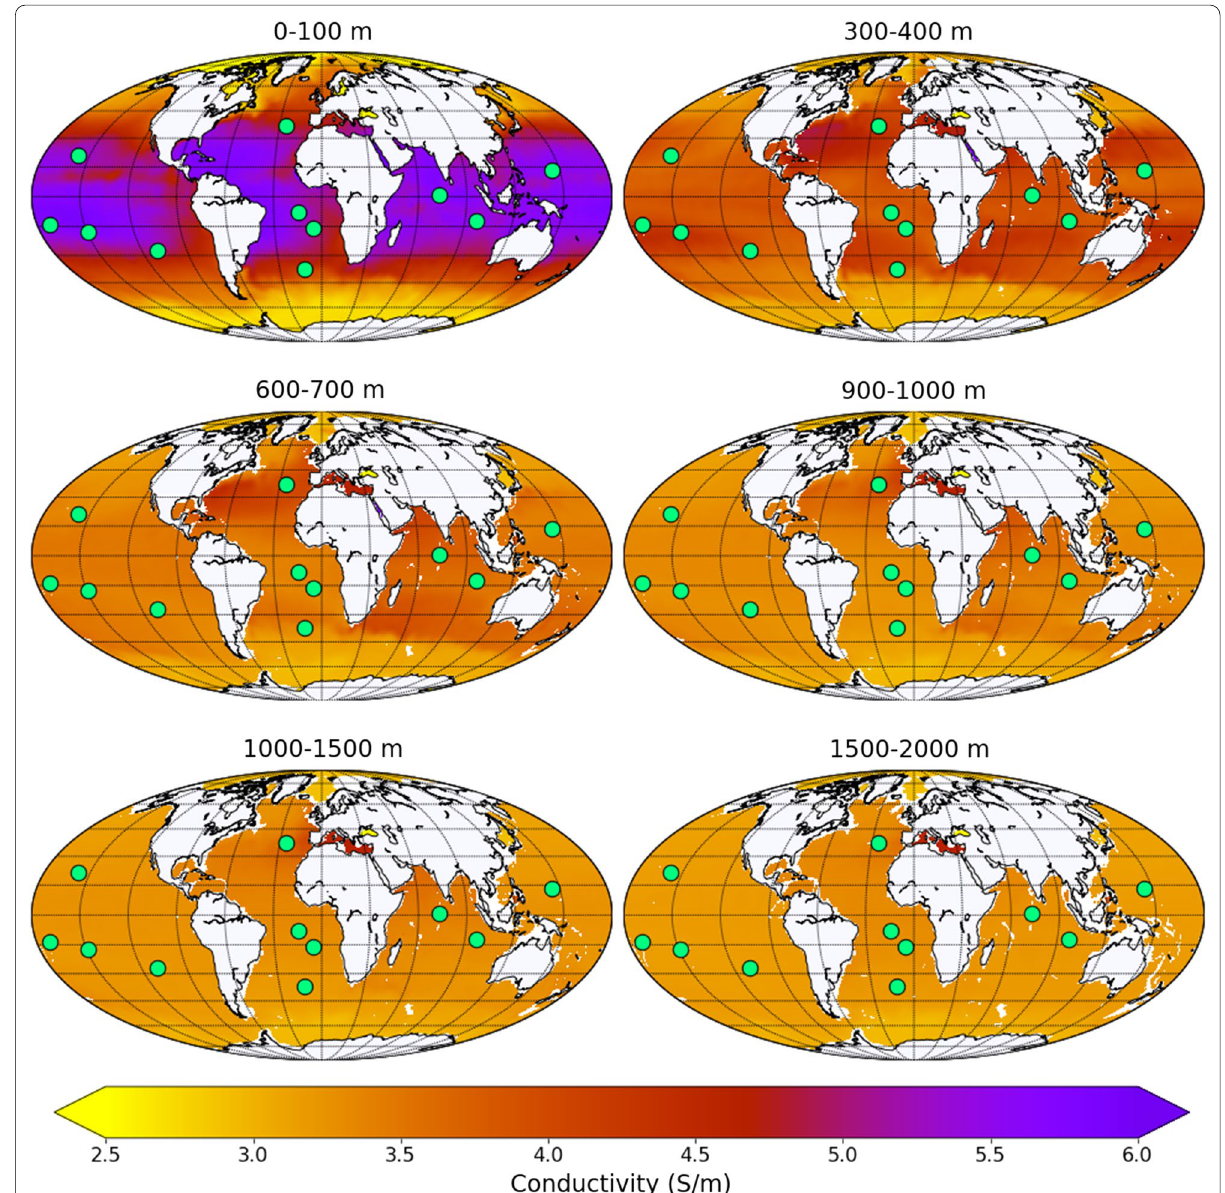
Fig. 2 Global maps of oceanic electric conductivity for six selected depth intervals for December 2015 model. Green dots denote the locations of the geomagnetic observatories used in this